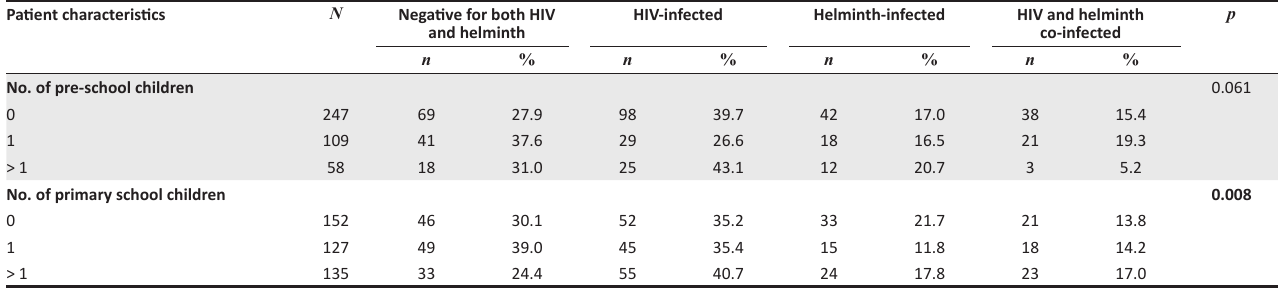
TABLE 2 (Continues...): Univariate association of HIV, helminth, and HIV-helminth co-infection with different demographic characteristics. Patient characteristics